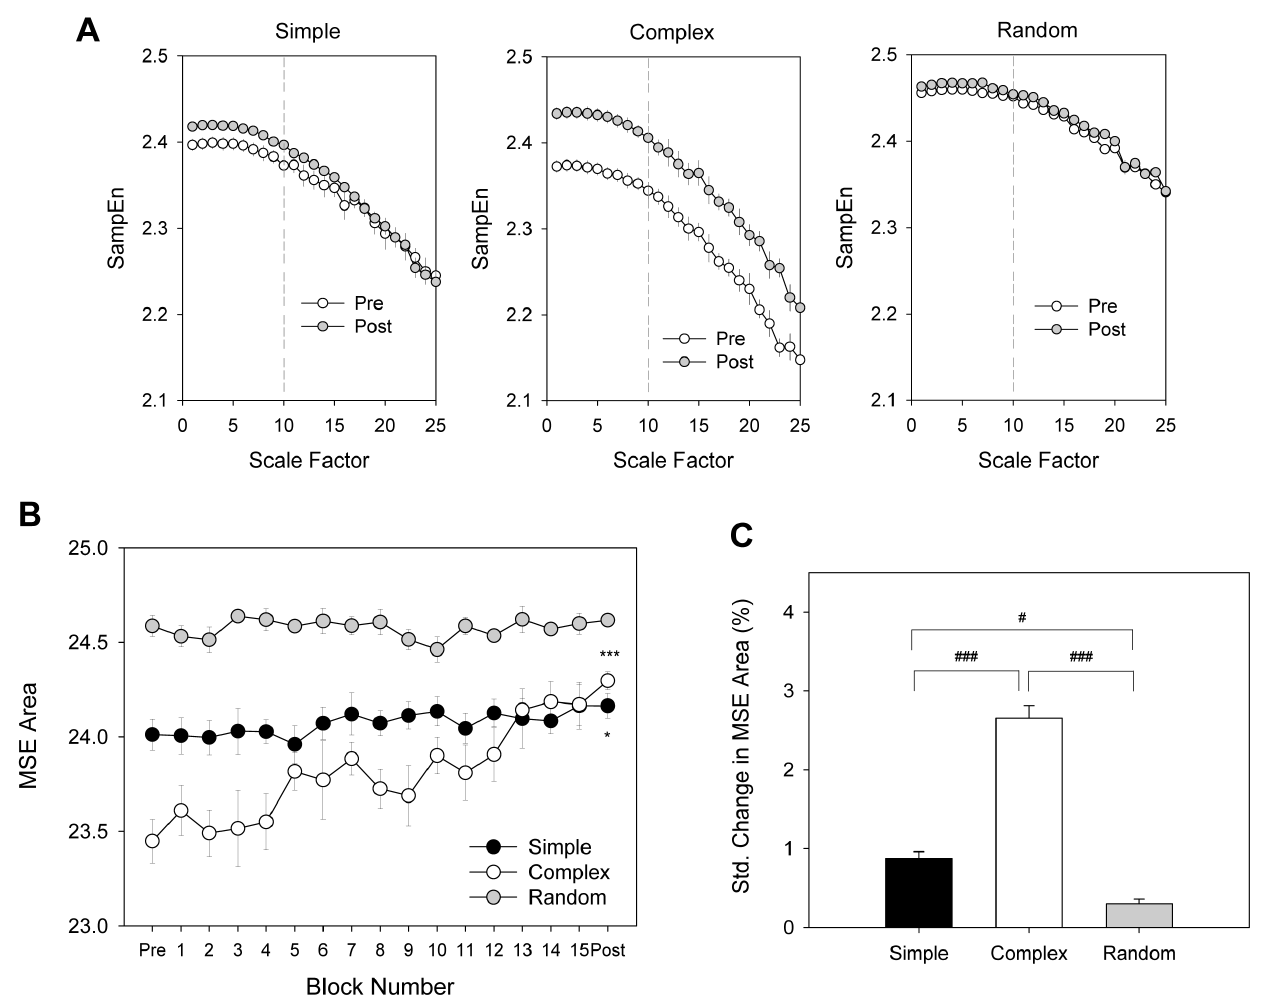
Figure 5. Multi-scale entropy (MSE) analysis of submovement profile for different practice protocols. (A) Pooled sample entropy versus scale factors of 1–25, (B) Evolutional change in MSE area under scale factors 1–10, and (C) Standardized change in MSE area due to practice effect. ( * : post-test . pre-test, p , 0.05; *** : post-test . pre-test, p , 0.001)( # : significant difference between protocols, p , 0.0167; ### : significant difference between protocols, p , 0.001).